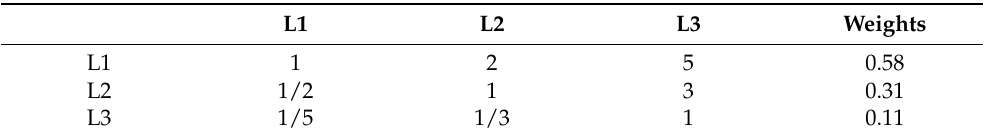
Figure 13. The result of TE and SE for industrial water from 2014 to 2019. Table 2. The weighting coefficient of each factor in the evaluation of water resource utilization water use